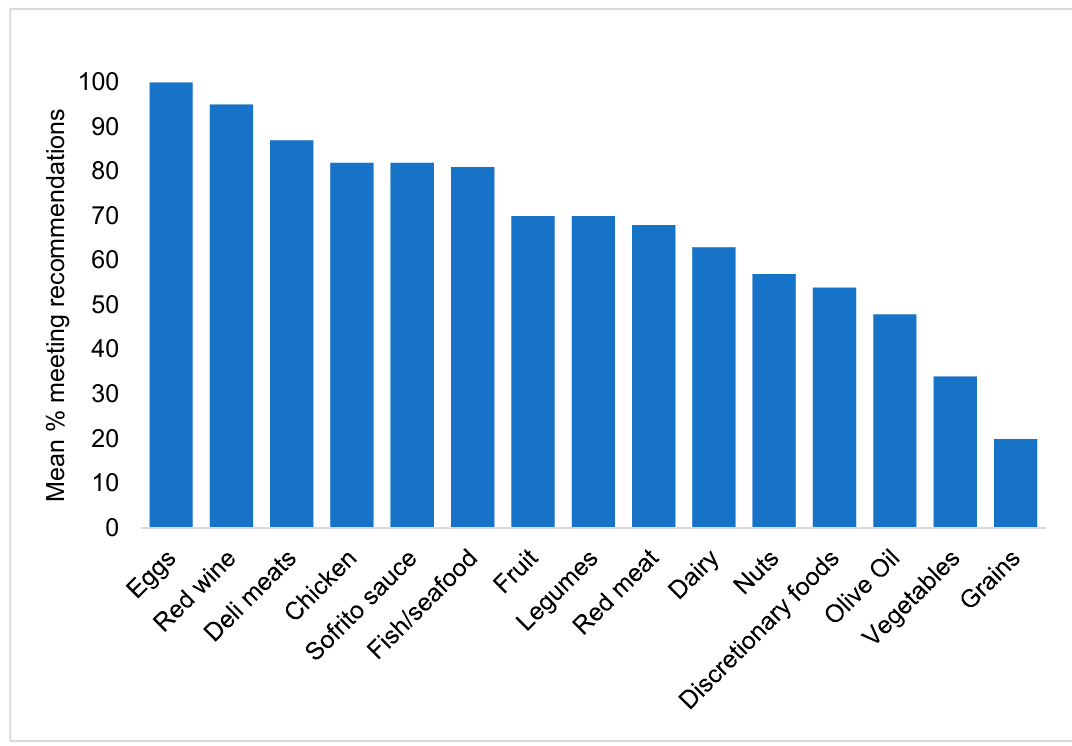
Figure 2. Percentage of participants meeting the dietary recommendations for each food group (mean of all weeks).